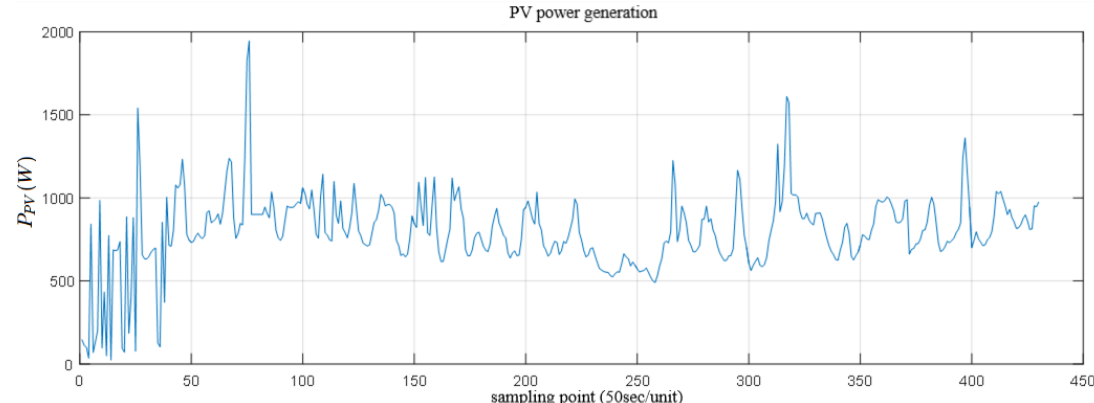
Figure 6. Frequency variation during the energy balance test phase.